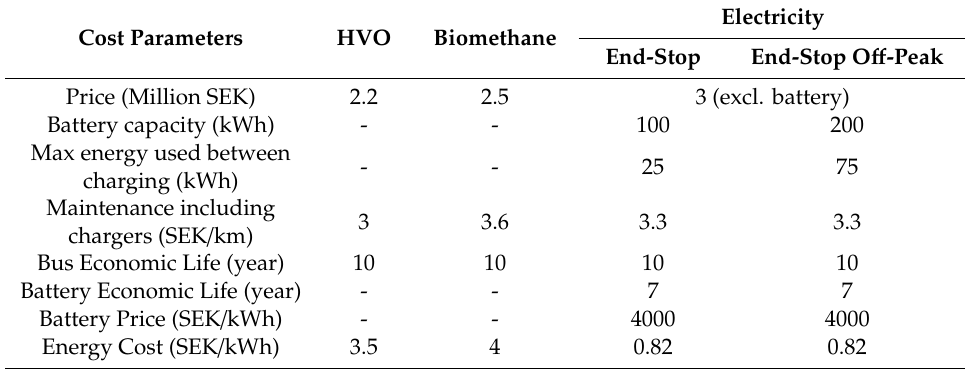
Table 1. The cost parameters for buses powered by HVO, biomethane, and electricity when charging at the end stop, and at the end stop only during o ff -peak time. The values are relevant for Sweden 2019, and based on results from pilot